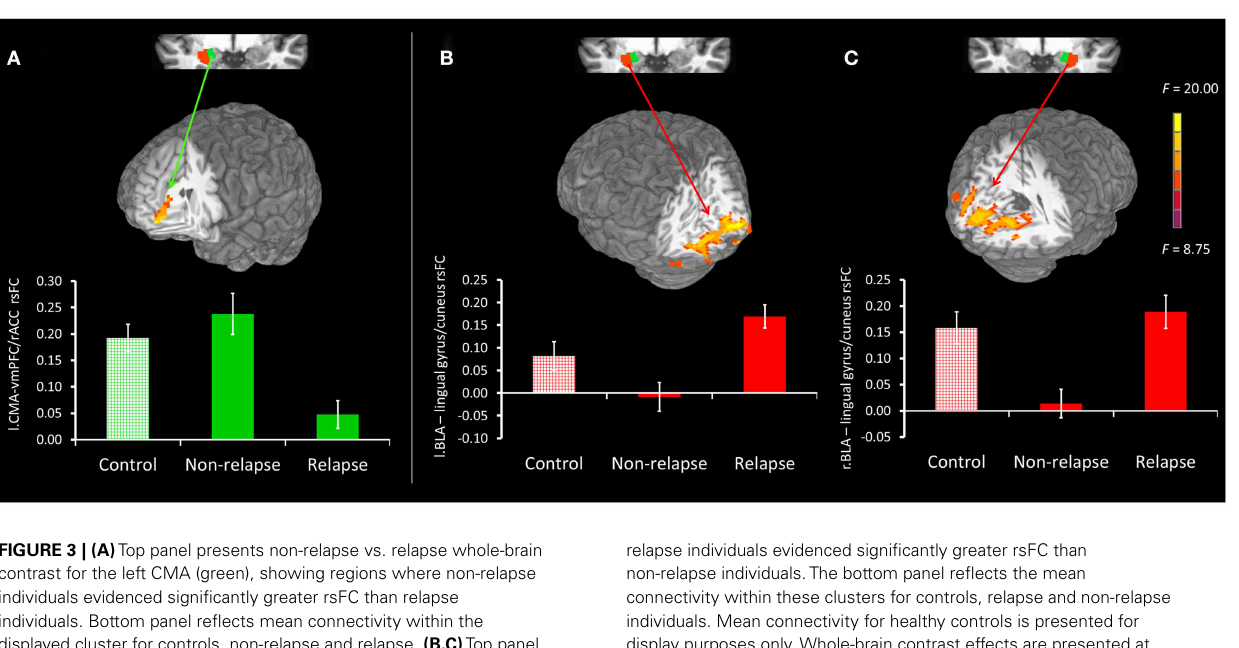
FIGURE 3 | (A) Top panel presents non-relapse vs. relapse whole-brain contrast for the left CMA (green), showing regions where non-relapse individuals evidenced significantly greater rsFC than relapse individuals. Bottom panel reflects mean connectivity within the displayed cluster for controls, non-relapse and relapse. (B,C) Top panel presents relapse vs. non-relapse whole-brain contrast for the left BLA (red) and right BLA (red) respectively. Clusters show regions where